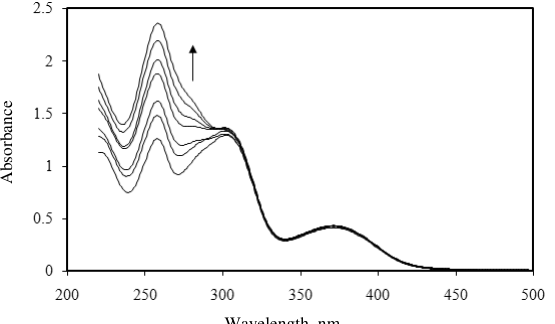
Figure 2. Absorption spectra of MTX in the presence of DNA in different concentrations. C = 0.0, 27.6, 55.3, 82.9, 110.6, 138.2 and 165.8 µ mol L -1 for curves 1-7 and DNA